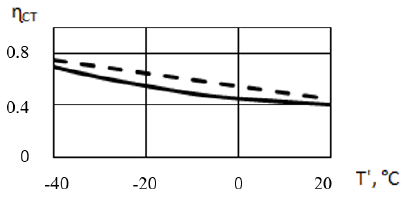
Figure 8. The irreversible energy absorption coefficient 𝜂 𝐶𝑇 .